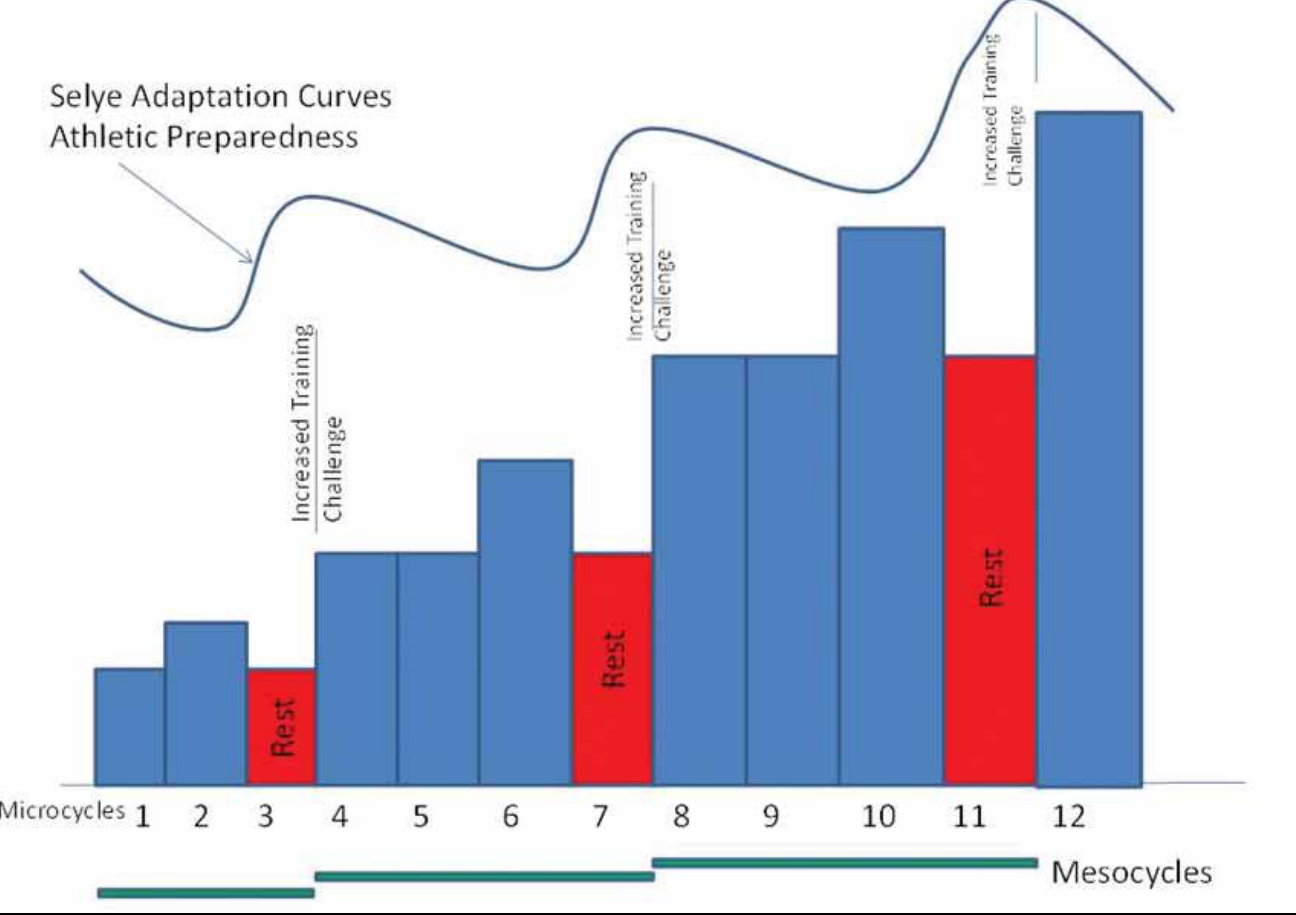
Figure 2-2. Combination of Training Design Aspects in Relation to the General Adaptation Syndrome